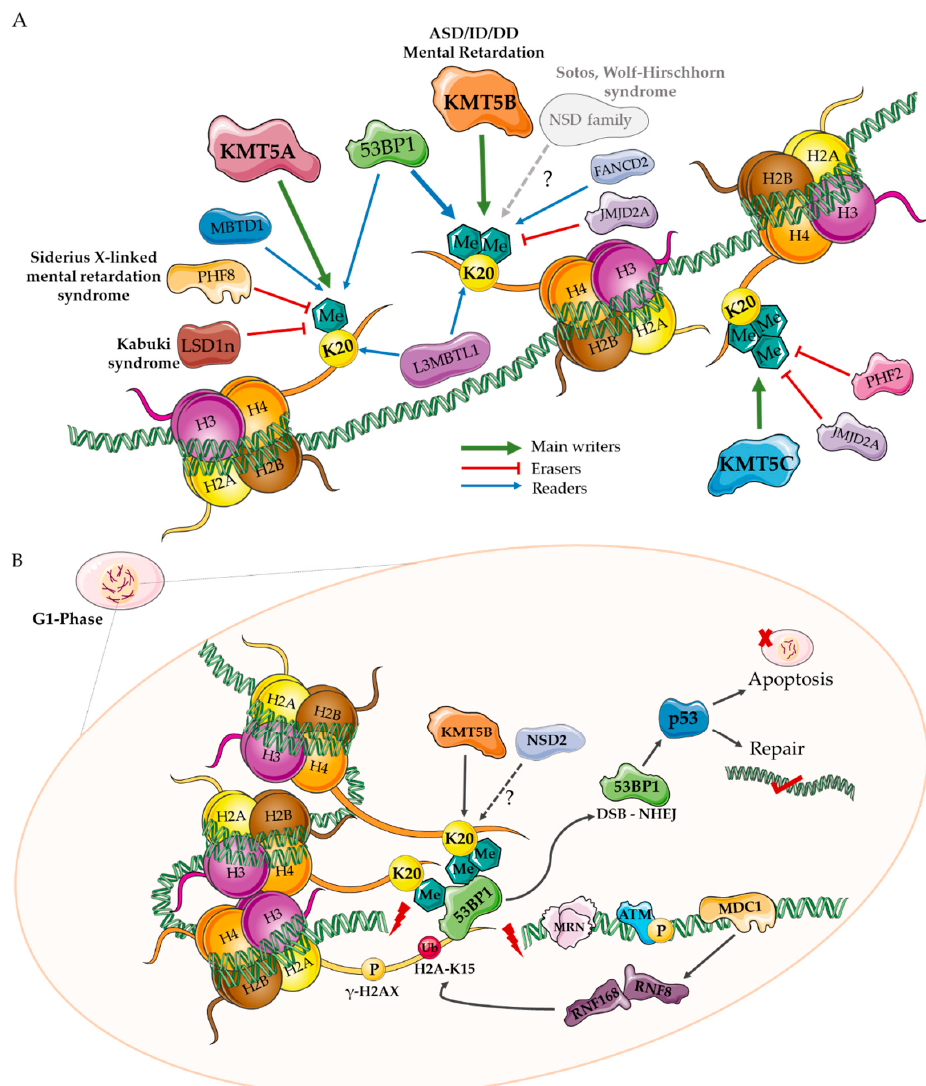
Figure 2. Diagram of major H4K20-related proteins and their proposed role in DNA double stranded break (DSB) repair. ( A ) Lysine methyl transferase (KMT) 5A, KMT5B, and KMT5C are the three main enzymes